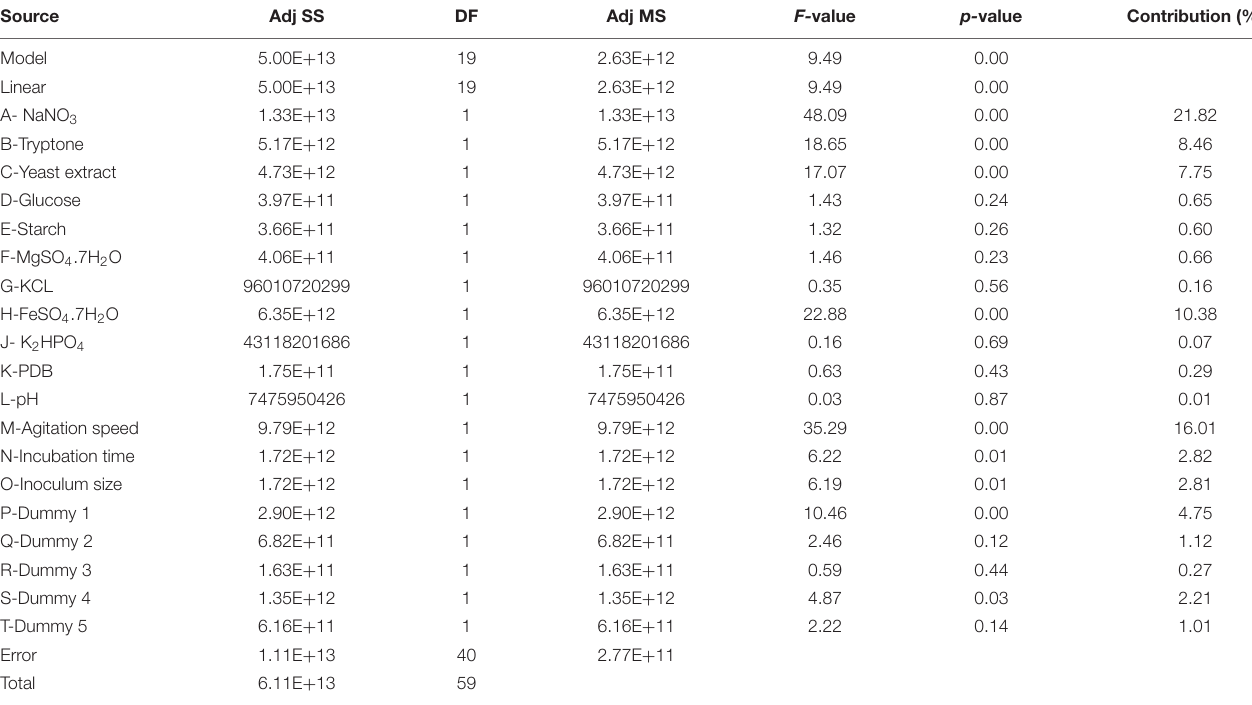
TABLE 4 | Regression statistics and analysis of variance (ANOVA) for the experimental results of Plackett–Burman design used for cyclopiazonic acid production by Penicillium commune KACC 45973. Source Adj